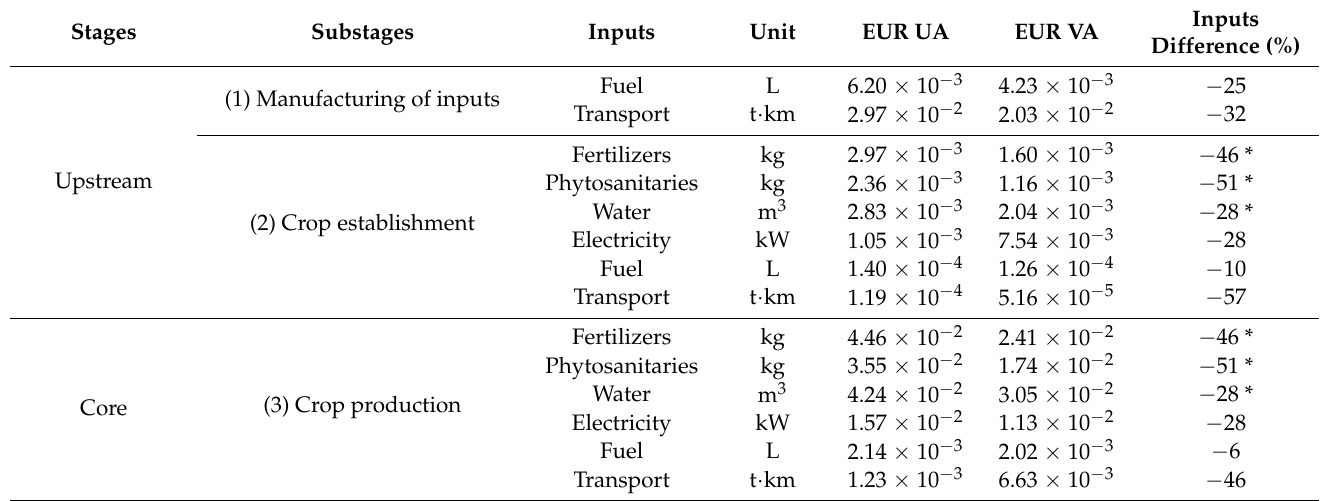
Table 4. Life cycle inventory of nectarines per FU (1 kg of fruit), in the UA and VA scenarios.